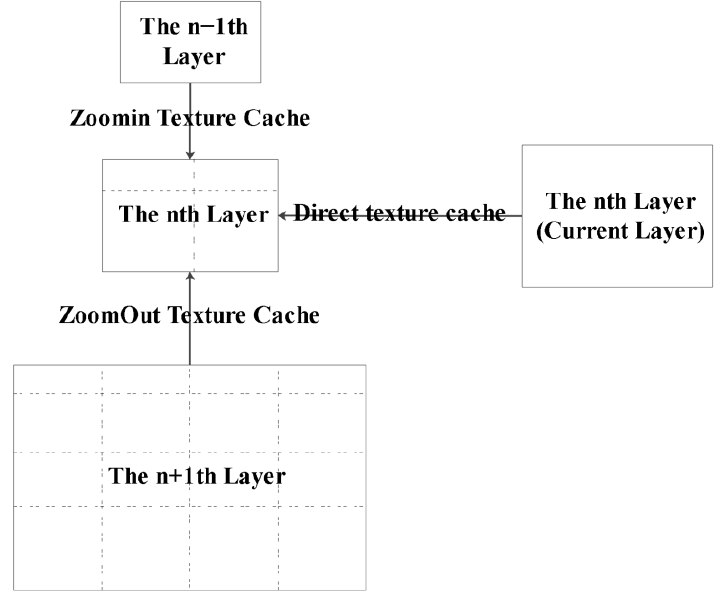
Figure 5. AR map symbol data pre-cache loading reuse principle.